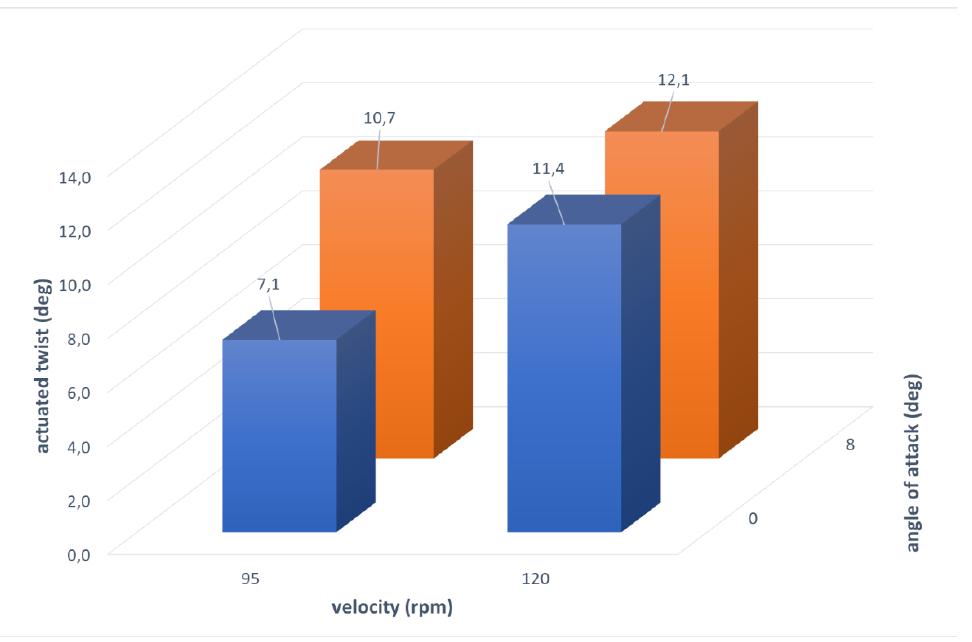
Figure 12. Twist of the blade corresponding to a span of 5 m against velocity and angle of attack.